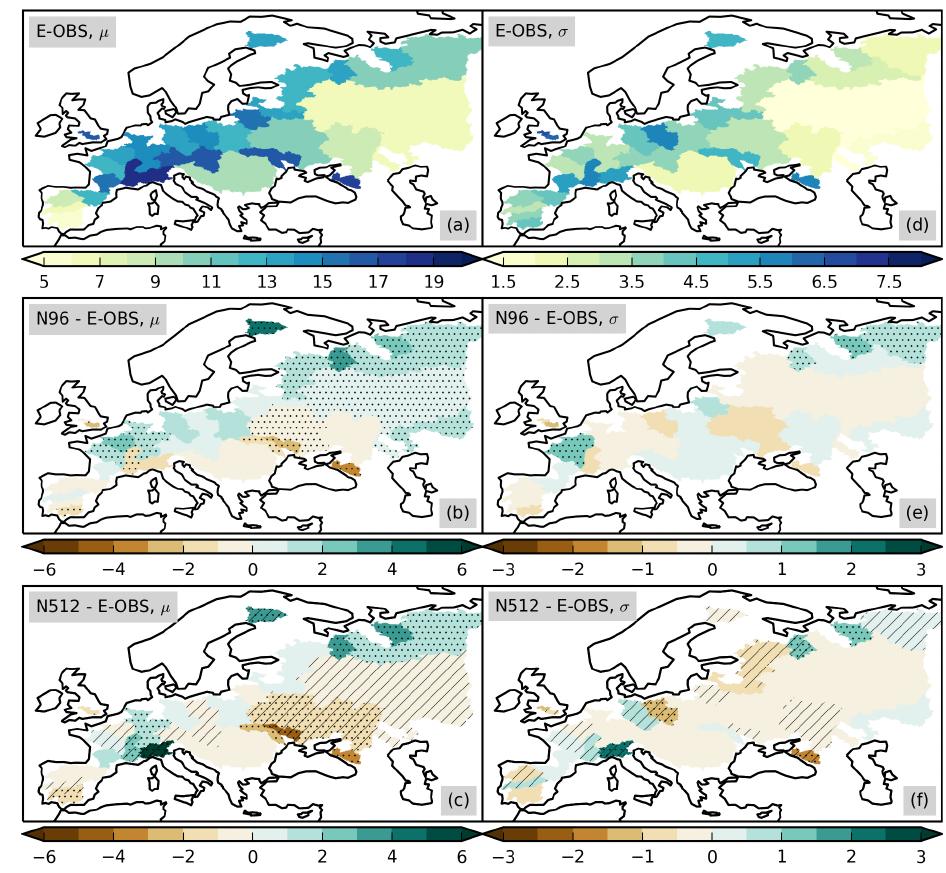
Figure 6. As Fig. 5 but for summer (June–August).